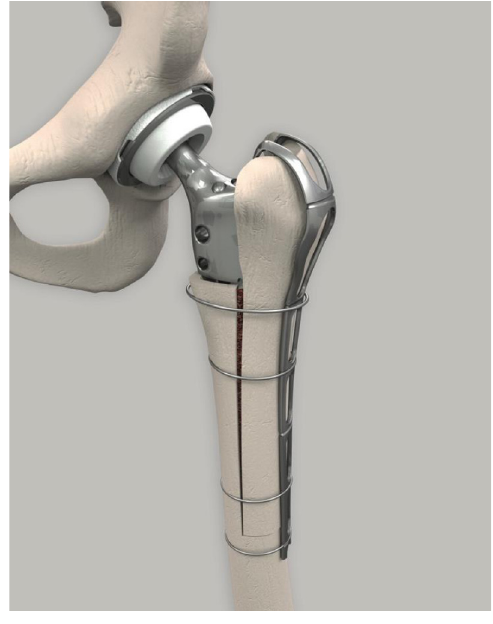
Figure 1. Metallic reinforcement plate (MRP) Integra R .